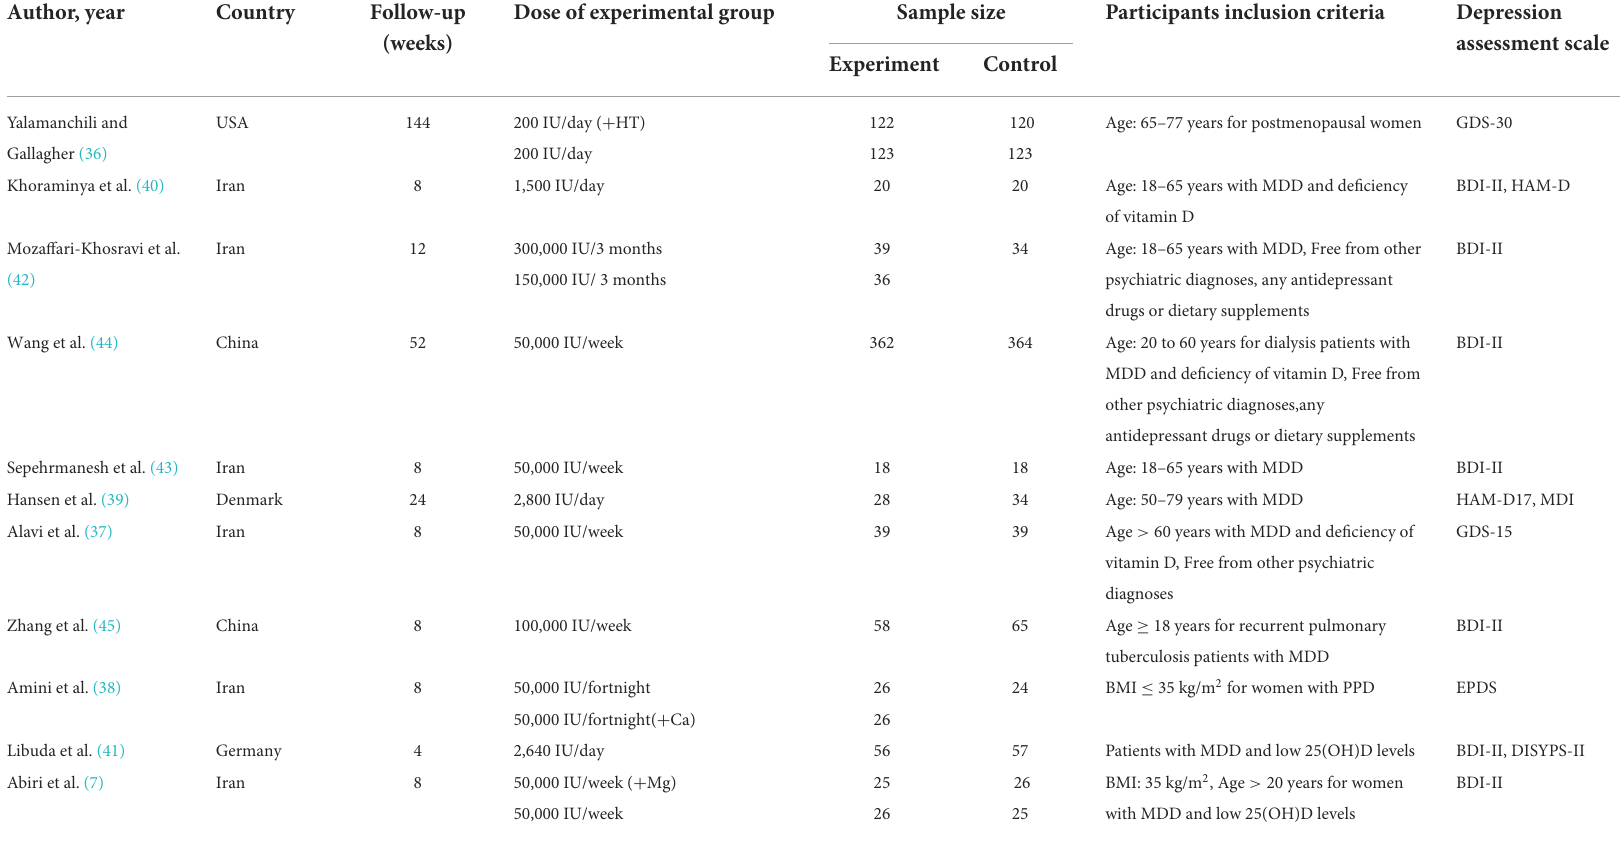
TABLE 2 The characteristics of studies included in this meta-analysis (the correlation between vitamin D and the prognosis of